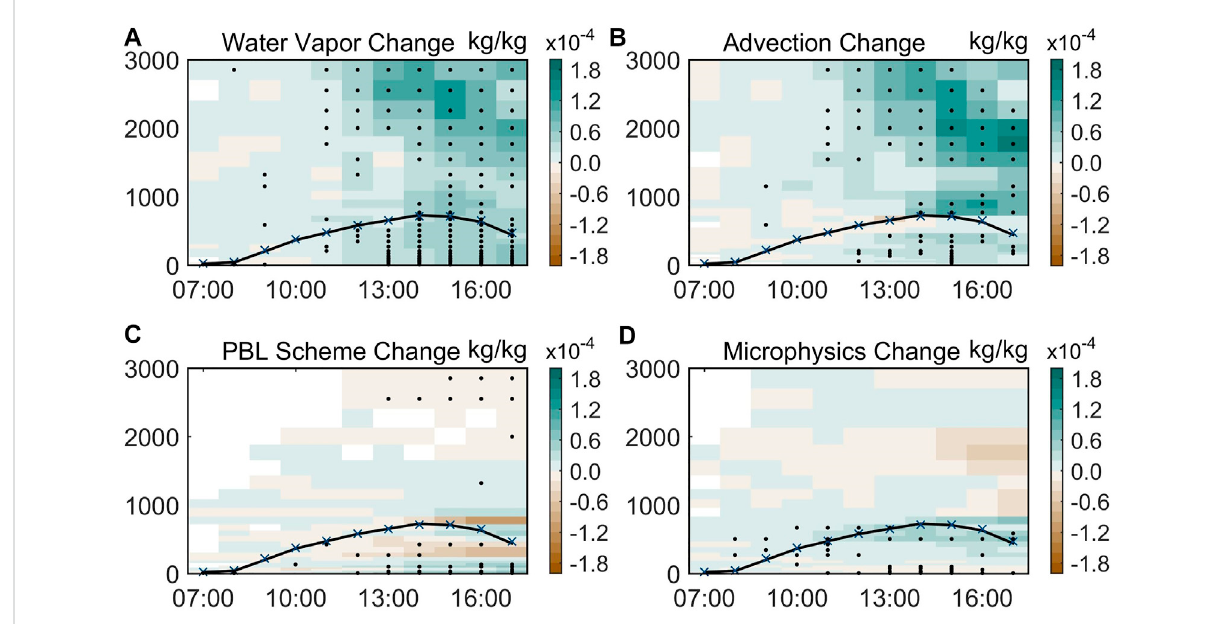
FIGURE 9 Process analysis of ensemble mean water vapor change by BC radiative effect in time-height section in the Shanghai case, averaged over the boxregionshowninFigure 3D. (A) Simulatedwater vapor change. (B – D) Simulatedaccumulated watervapor changedue toadvection,PBLscheme (including surface evaporation and vertical turbulent mixing) and microphysics process, respectively. The sum of each individual process (B – D) equalstothetotaltemperaturechangein (A) .BlacksolidlinesrepresentPBLheightinthesimulationwithaerosolradiativefeedback(BASE300). Blue crosses represent PBL height in the simulation with aerosol radiative feedback except BC. (AeroRadexBC). Stilted grids indicate signi fi cant differences at the 5% signi fi cance